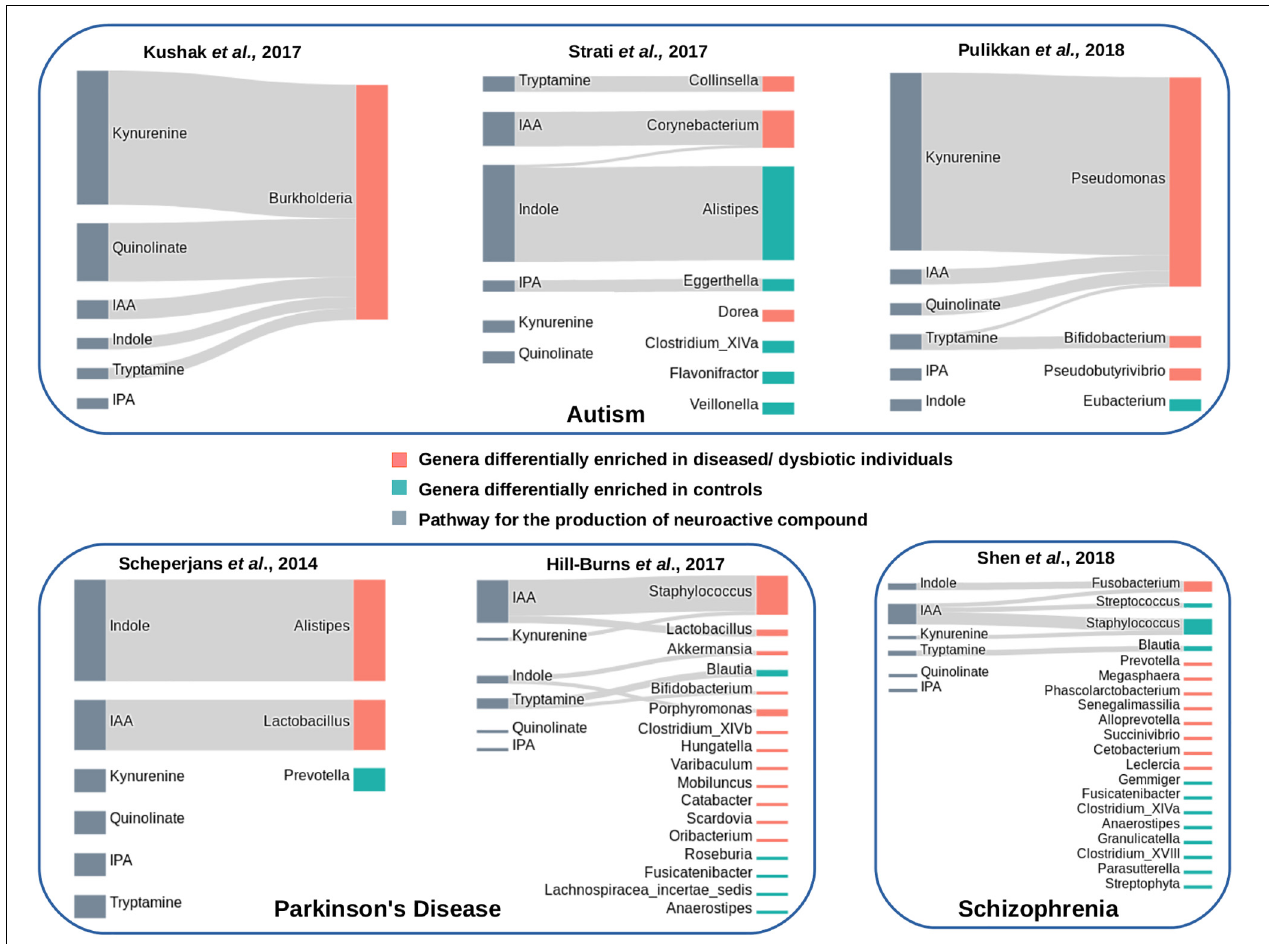
FIGURE 7 | Tryptophan metabolism pathways in differentially abundant genera in gut microbiome of patients suffering from neurological diseases and healthy individuals. Each panel corresponds to a set of microbiome data obtained from patients of a neurological disease and matched healthy individuals. The genera differentially enriched in diseased cohorts have been shown with orange bars, while those differentially abundant in healthy cohorts have been shown with cyan bars. The pathways that have been predicted in differentially abundant genera in diseased or healthy individuals have been represented by Sankey diagrams. The width of the pathway-genus association represents the “SCORBPEO” value of the genus for the respective pathway.